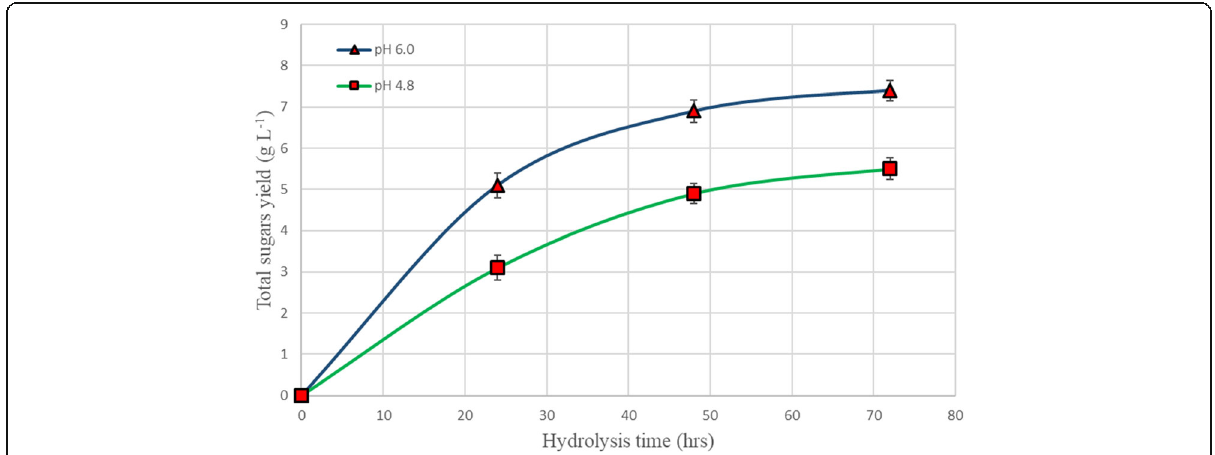
Fig. 5 Total reduced sugar yield at the end of hydrolysis (72 h) for pH 4.8 and